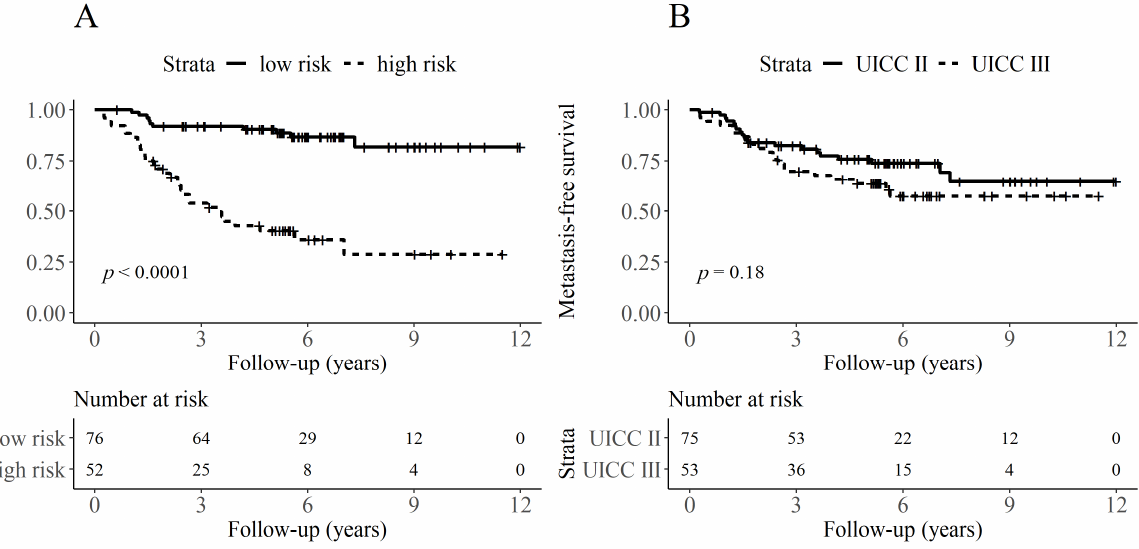
Table 2. Multivariable Cox regression for occurrence of metastasis.